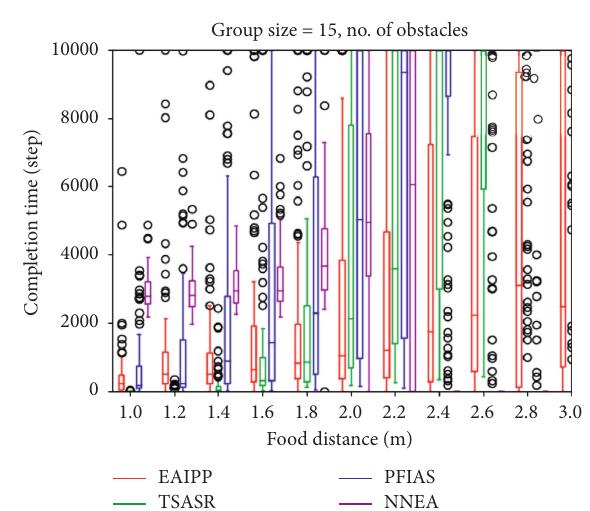
Figure 11: Box-and-whisker plots (Becker et al.1998 [41]) showing 100 evaluations per box of the completion times with varying Robot_Nest-to-Robot_Food distances for a group of 15 robots in an environment without obstacles. See Figure 10 for an explanation of box-and-whisker plots.